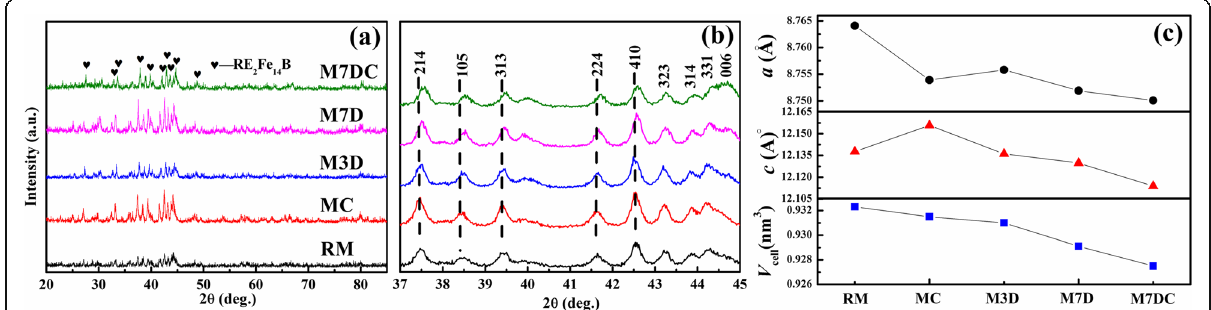
Fig. 1 a XRD patterns of samples annealed at 700 °C; b enlarged XRD patterns with slow scanning from 37° to 45°; c lattice parameters a , c , and cell volume for the